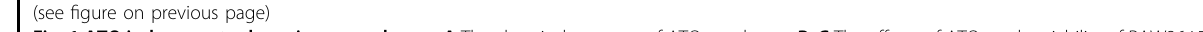
Fig. 1 ATO induces autophagy in macrophages. A The chemical structure of ATO are shown. B , C The effects of ATO on the viability of RAW264.7 cells and foam cells with the application of different concentrations (0, 2.5, 5, 10, 20 μ M) of ATO for different times (4, 12, 24, 48 h) as indicated. Cell viability was measured by MTT assay. D Atg7 mRNA expression in RAW264.7 cells were analyzed by RT-qPCR after treatment with or without 2.5 μ M ATO for 1, 2, 4 h. * p vs. the control group, # p vs. the ATO (2.5 μ M, 1 h) group. E , F Atg5 and LC3 mRNA expression levels in RAW264.7 cells were analyzed by RT-qPCR after treatment with ATO (0, 1.25, 2.5, 5, 10 μ M) for 2 h. * p vs. the control group. # p vs. the ATO (1.25 μ M, 2 h) group. G Atg7 mRNA expression was analyzed by RT-qPCR. * p vs. the control group, # p vs. the ATO group. H , I Western blot analysis of autophagy speci fi c proteins including LC3II/LC3I and p62/SQSTM1 in RAW264.7 cells after treated with ATO (2.5 μ M) for 1, 2, or 4 h. J , K Three speci fi c concentrations of ATO (2.5, 5, 10 μ M) were applied for 2 h and protein levels of LC3I, LC3II, and p62 were detected by western blots. L , M RAW264.7 cells were treated with or without autophagic fl ux inhibitor CQ (10 μ M) for 2 h followed by treated with or without ATO (2.5 μ M) for 2 h. Cells were then harvested for western blots to examine p62 and LC3II/I. N – Q RAW264.7 cells were treated with or without 3-MA (2.5 mM) for 2 h and then treated with or without ATO (2.5 μ M) for 2 h. N , O The imaging of LC3 (green), p62 (green) and DAPI (blue) in RAW264.7 cells were examined by fl uorescence microscopy. Scale bars = 20 μ m. P , Q Acidic organelles formation were analyzed by staining with Acridine Orange (AO) and DAPI was added to label nuclei (blue). Scale bars = 5 μ m. Data were expressed as mean ± SD from 3 independent experiments. * p < 0.05, ** p < 0.01, *** p < 0.001, # p < 0.05, ## p < 0.01, ### p < 0.001, and ns means non-signi fi